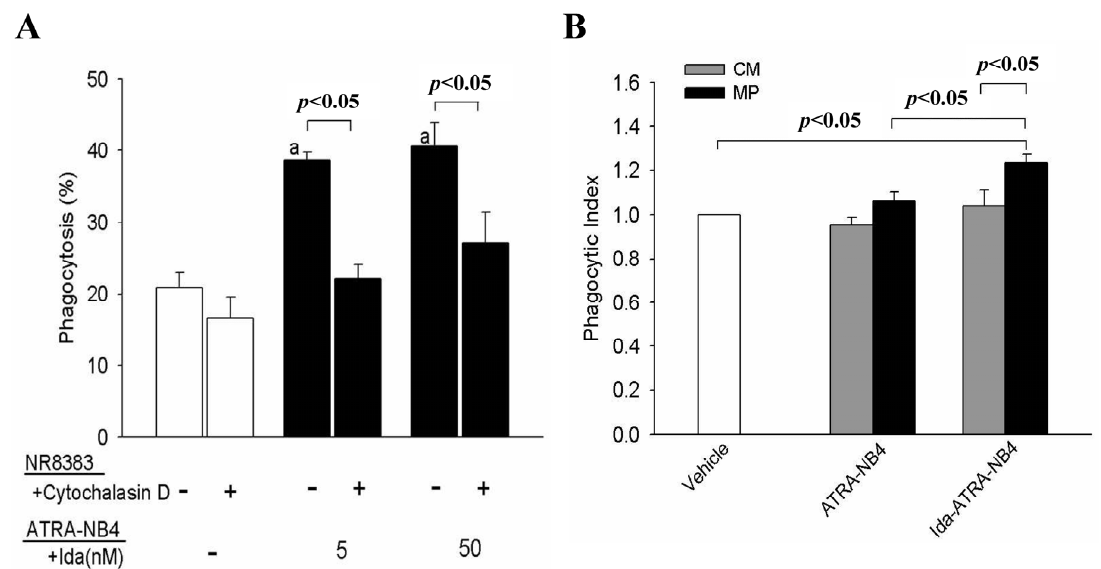
Figure 1. Apoptotic cell-derived MP enhance the phagocytic activity of NR8383 cells. ( A ) NR8383 cells were incubated with either Ida-untreated (blank bar) or Ida-treated (black bar) ATRA-NB4 cells, in the absence or presence of cytochalasin D, before the phagocytic assay. The results are expressed as the percentage of NR8383 cells engulfing ATRA-NB4 cells.